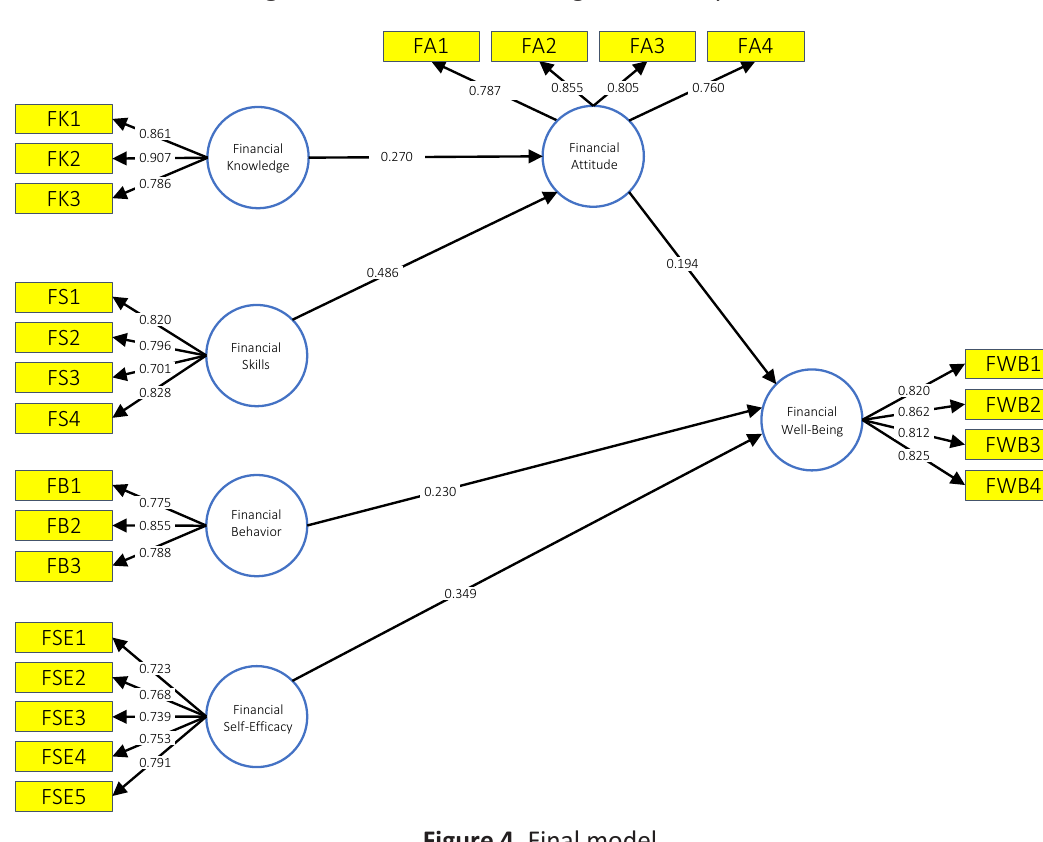
Figure 3. The first PLS-SEM algorithm analysis results